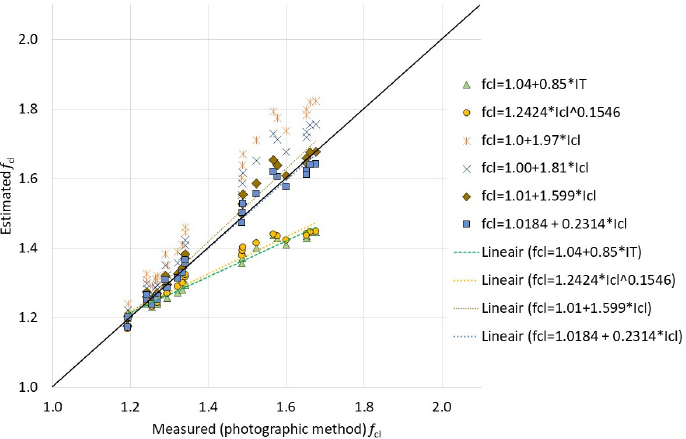
Figure 2. Relationship between the measured and the estimated clothing area factors for the firefighter clothing system by various available equations. f cl (or fcl)—clothing area factor; IT—total clothing insulation; Icl—basic clothing